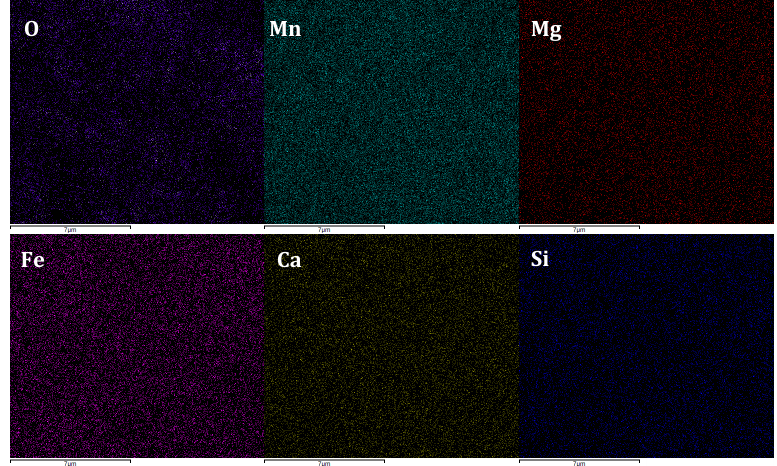
Figure 10. Multi-element energy dispersive spectrometry (EDS) mapping images of the filter media collected on the 20th day in filter R3.